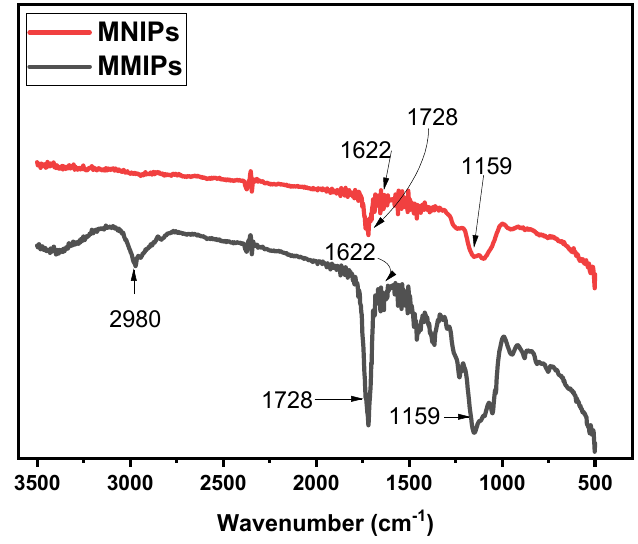
Figure 2. FTIR spectra obtained to MMIPs and MNIPs.